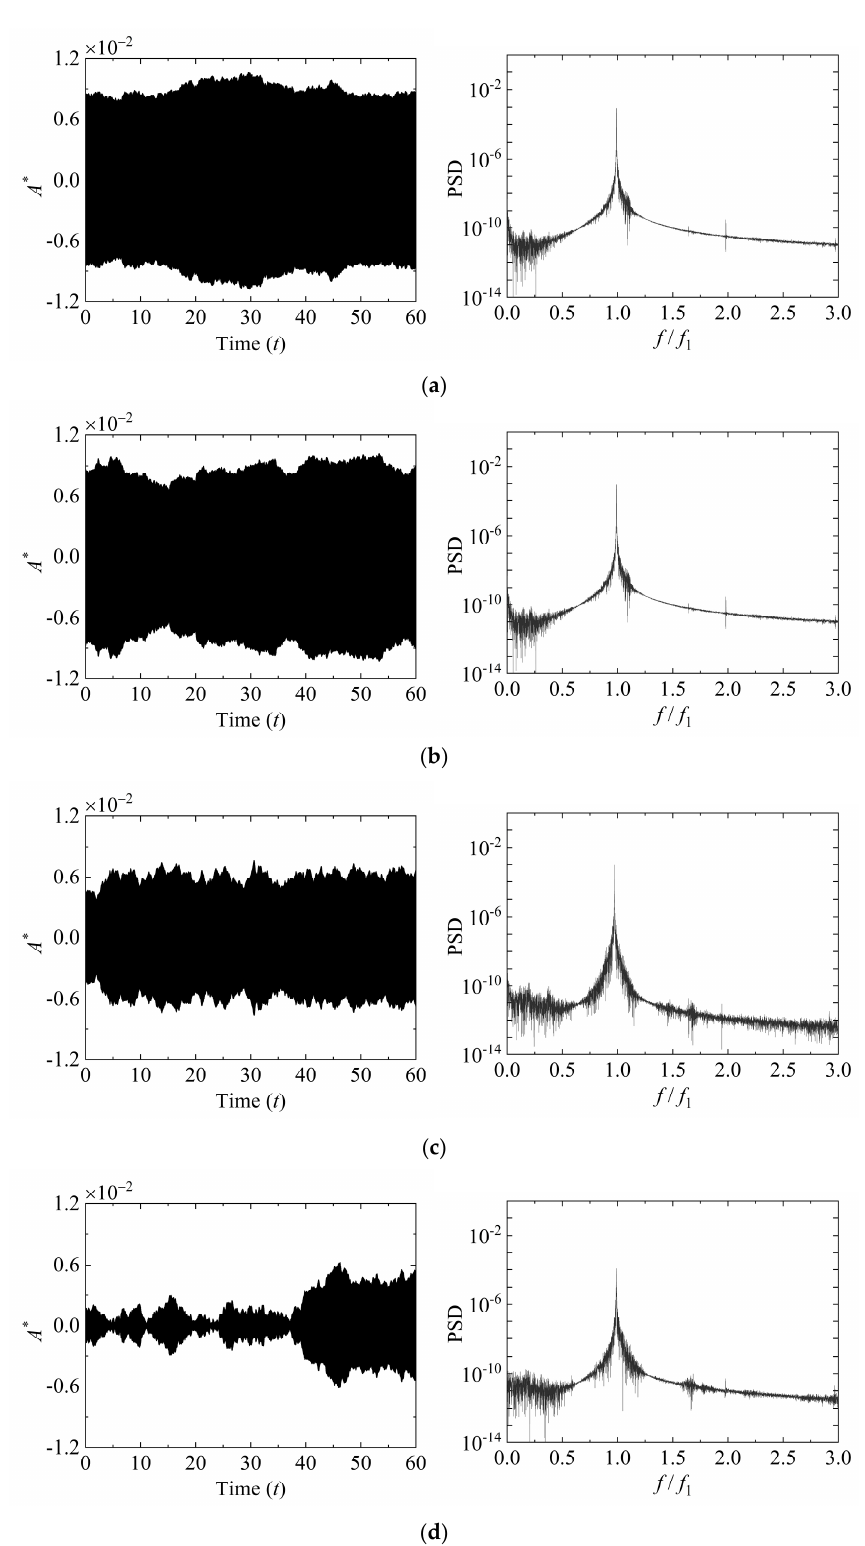
Figure 17. Comparison of the dimensionless displacement time histories and PSD for different yawed angles ( α ) at the critical wind speeds. ( a ) α = 10° ( V* = 5.02); ( b ) α = 20° ( V* = 5.11); ( c ) α = 30° ( V* = 4.93); ( d ) α = 40° ( V* = 5.35).